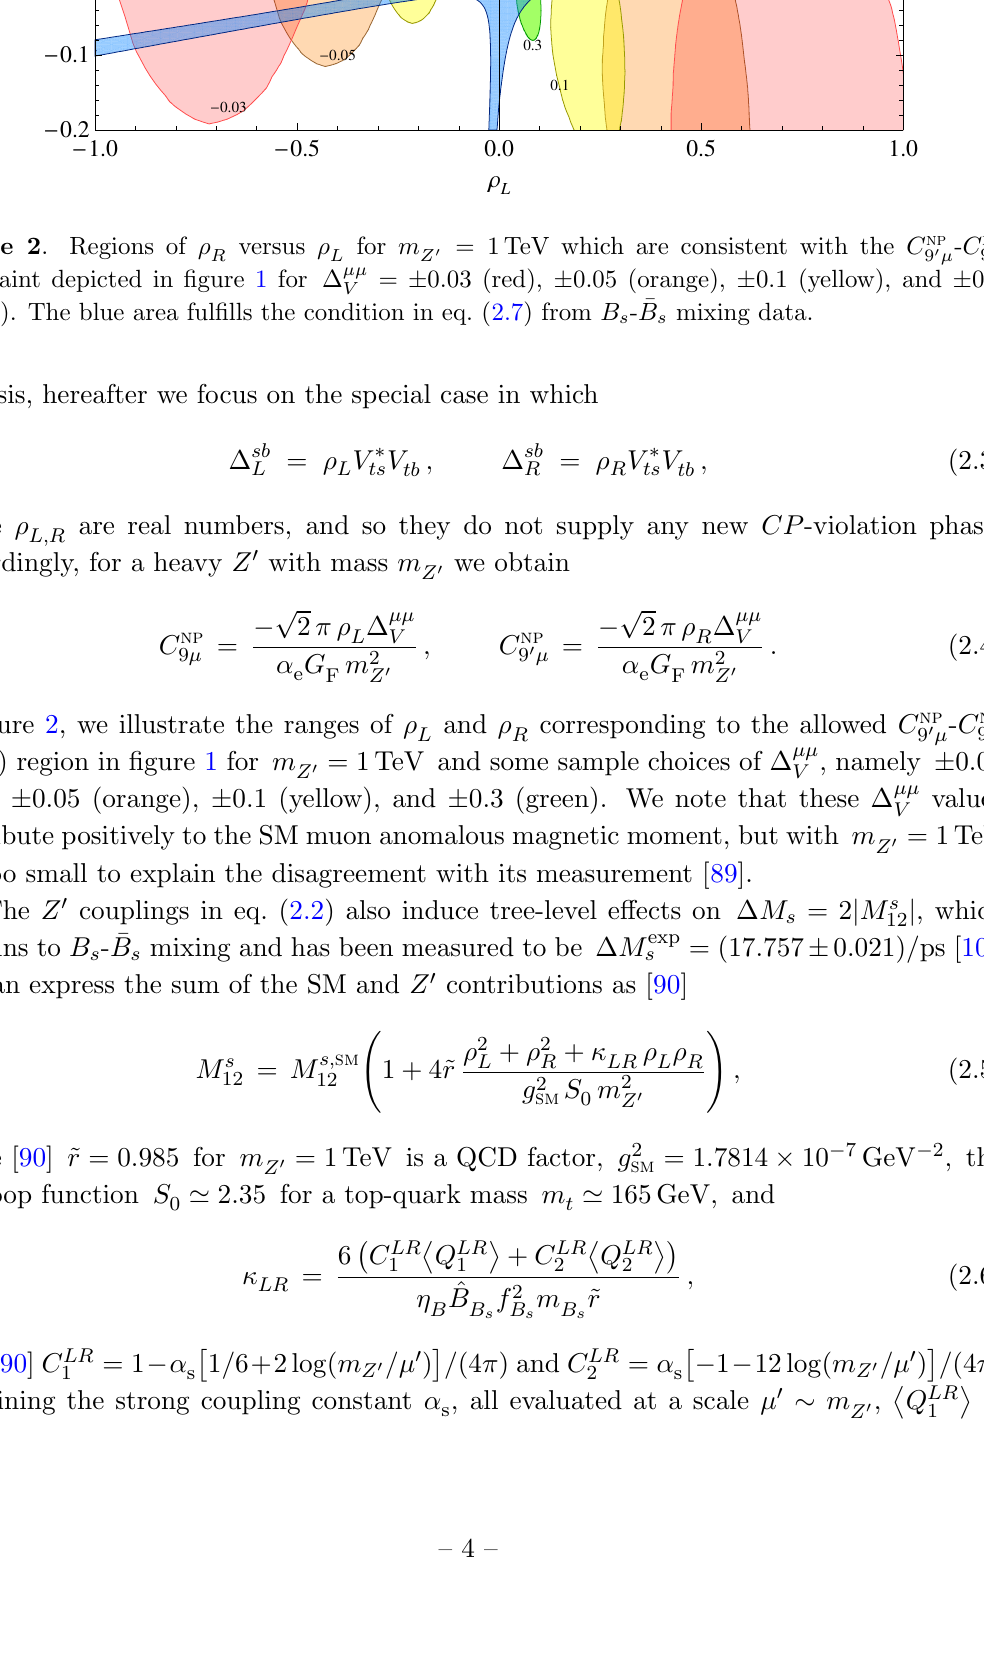
- C np 9 (cid:22) 9 0 (cid:22)